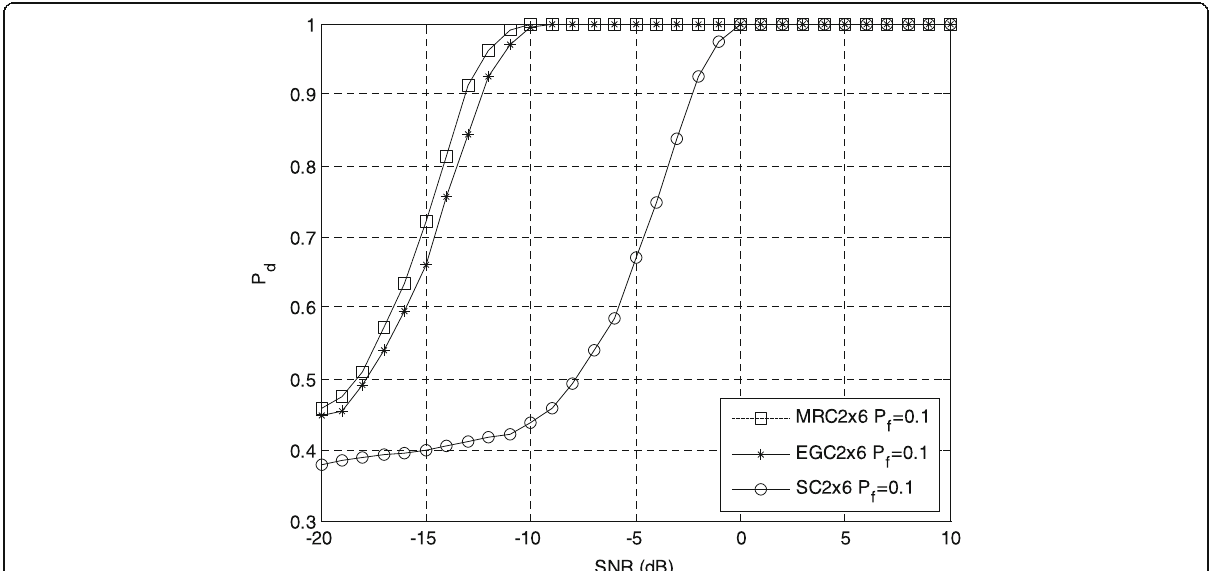
Fig. 8 Performance comparison of the three combining detection methods in 2 × 6 MIMO system